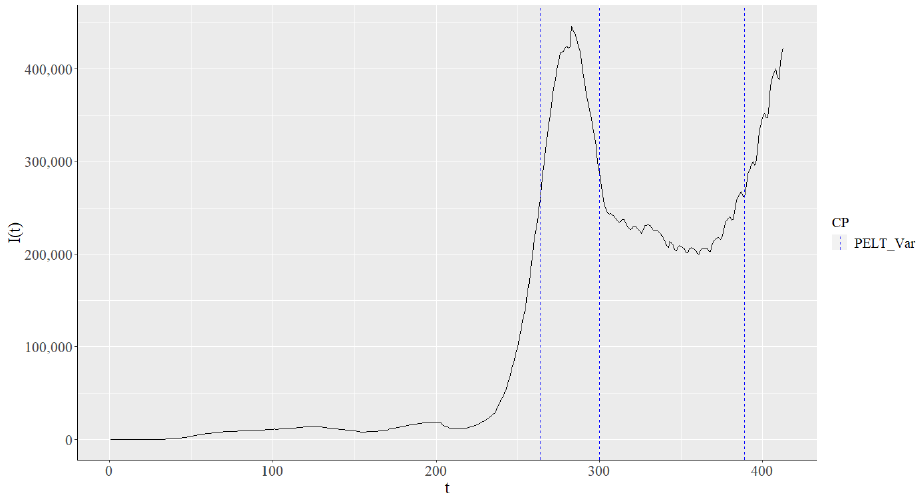
Figure 11. Specific variance detection of CPs in COVID-19 infection using